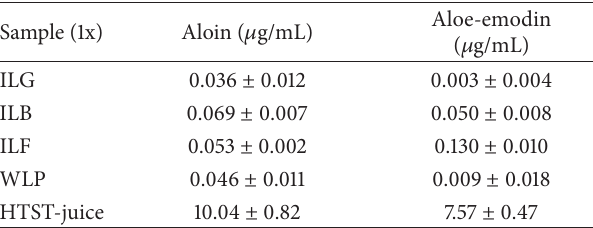
Table 1: Concentration of aloin and aloe-emodin in different commercial starting products at the concentration 1x compared to the raw extract (HTST-juice). Values are expressed as mean ± 1,96 ∗ SEM ( 𝑛 = 3